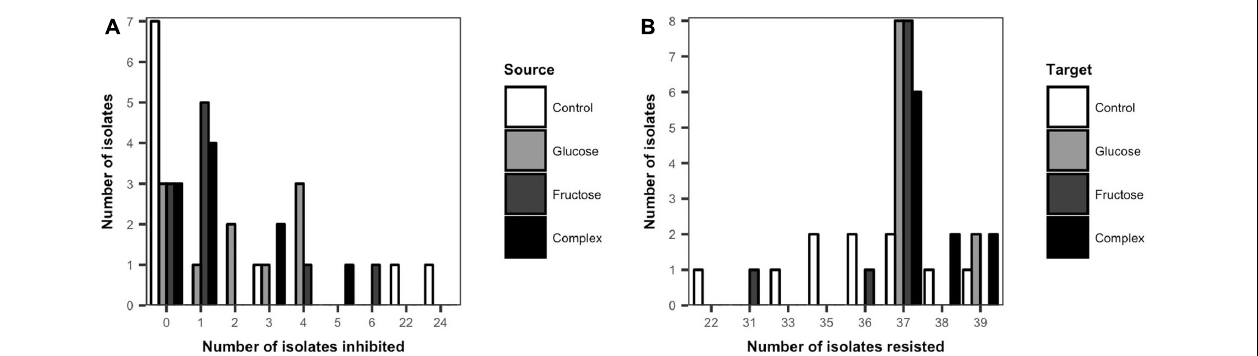
FIGURE 3 | Frequency distribution of cumulative inhibitory (A) and resistant (B) phenotypes of Streptomyces from carbon-amended and non-amended soils. Each bar represents the number of source Streptomyces isolates ( n = 10 isolates per treatment) that inhibited any of the Streptomyces target isolates from all the treatments ( n = 39) (A) , or the number of target Streptomyces isolates ( n = 10 isolates per treatment) that resisted inhibition by any of the source Streptomyces isolates from all the treatments ( n = 39) (B) . Inhibitory interactions were determined by the presence of complete inhibition zones ( > 2 mm) representing the lack of growth of a target isolate in association with a source isolate on agar plates. Resistant interactions were determined by the presence and size of incomplete inhibition zones ( < 2 mm) representing the growth of a target isolate and the lack of inhibition by a source isolate on agar